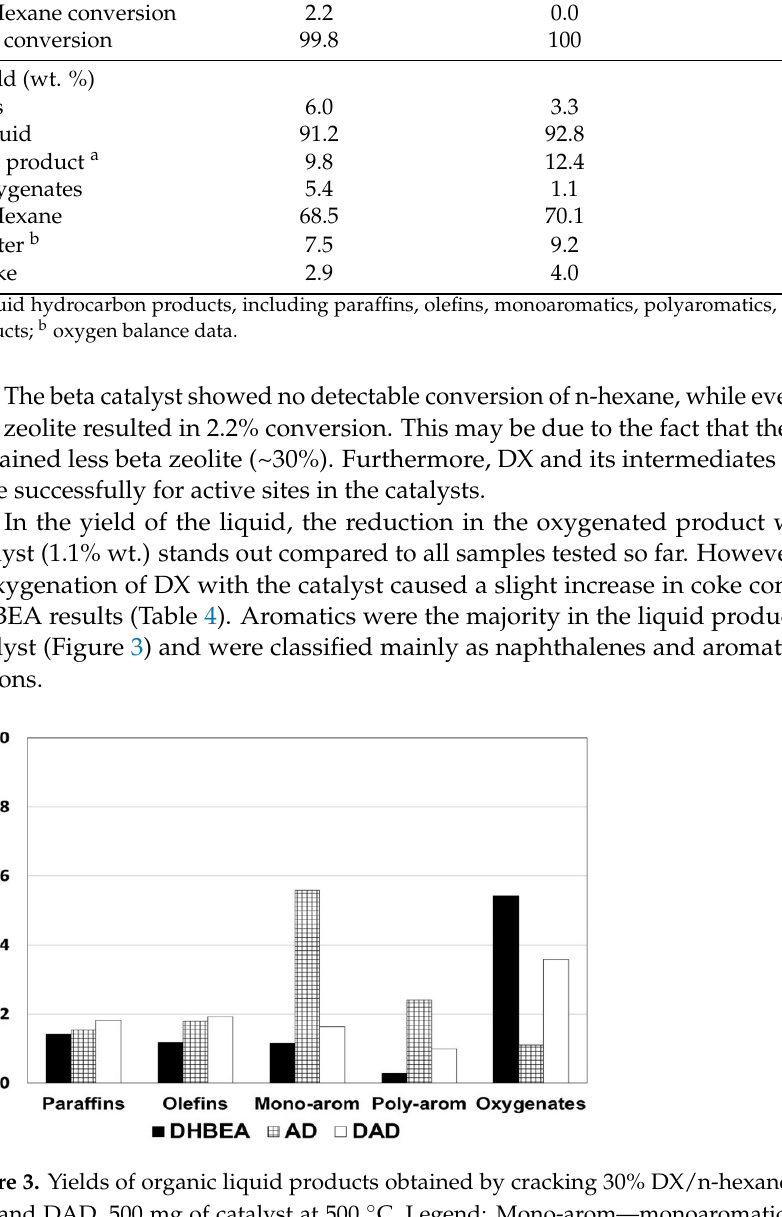
Table 5. Yields of gases by percentage of DX obtained by catalytic cracking of 30% DX in n-hexane on beta zeolite, beta catalyst hydrothermally treated at 720 °C, and fresh beta catalyst, 500 mg of catalyst at 500 °C of reaction.